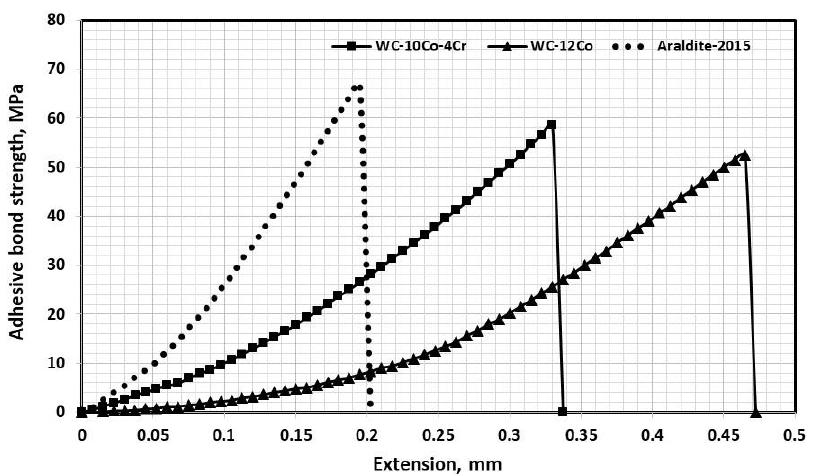
Figure 19. Adhesion bond strength vs. extension plots for adhesive and both types of coatings.